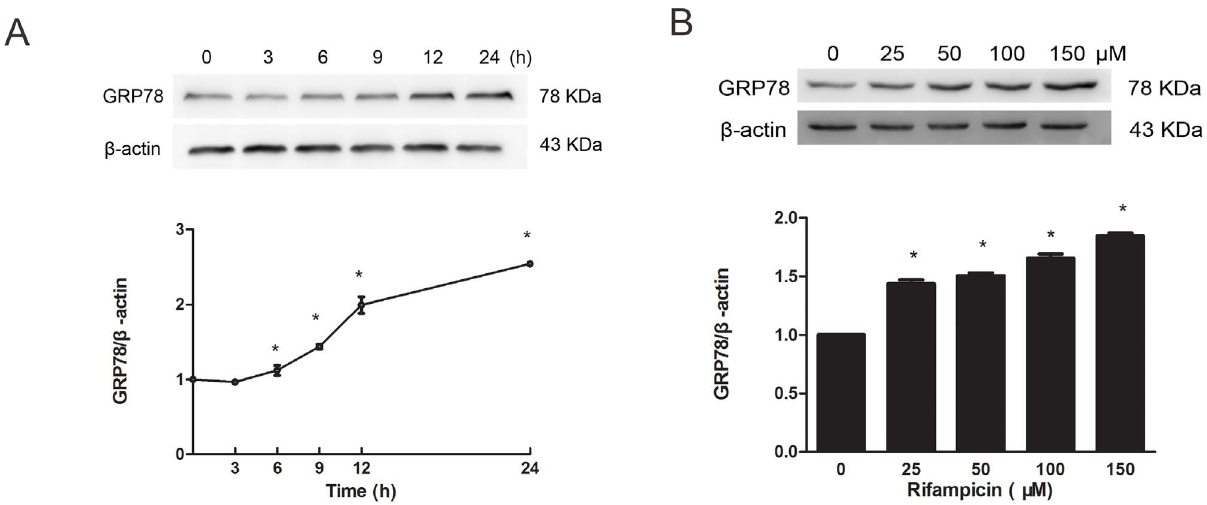
Figure 2. Rifampicin induced a time- and dose-dependent GRP78 activation. (A) Cells were treated with rifampicin at 150 m M for indicated periods of time. Western blot analysis showed that rifampicin significantly upregulated GRP78 protein expression at 6 h post-treatment. Prolonged rifampicin incubation further enhanced GRP78 induction up to 24 h after treatment. (B) Cells were treated with rifampicin at indicated concentrations, followed by western blot analysis to measure GRP78 activation. Rifampicin induced a dose-dependent upregulation of GRP78 expression. Protein expression was relative to control cells, in which GRP78 expression was deemed to be 1. Data present mean 6 SEM of three independent experiments. *p , 0.05 compared with control